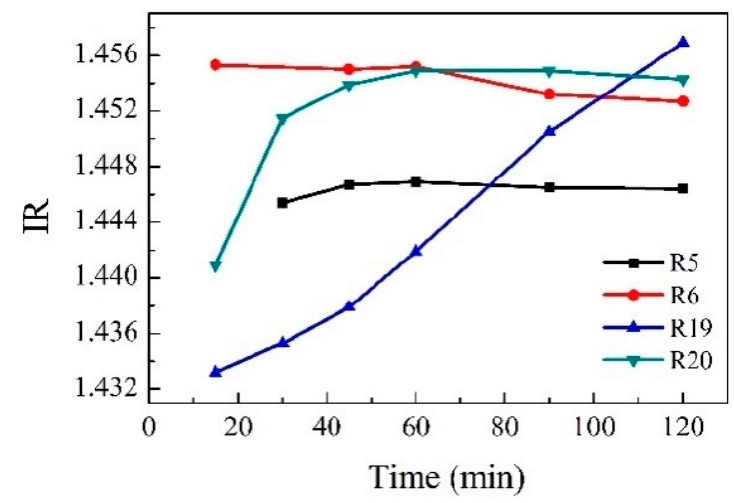
Figure 8. IR of Reactions 5, 6, 19, and 20 at different times.